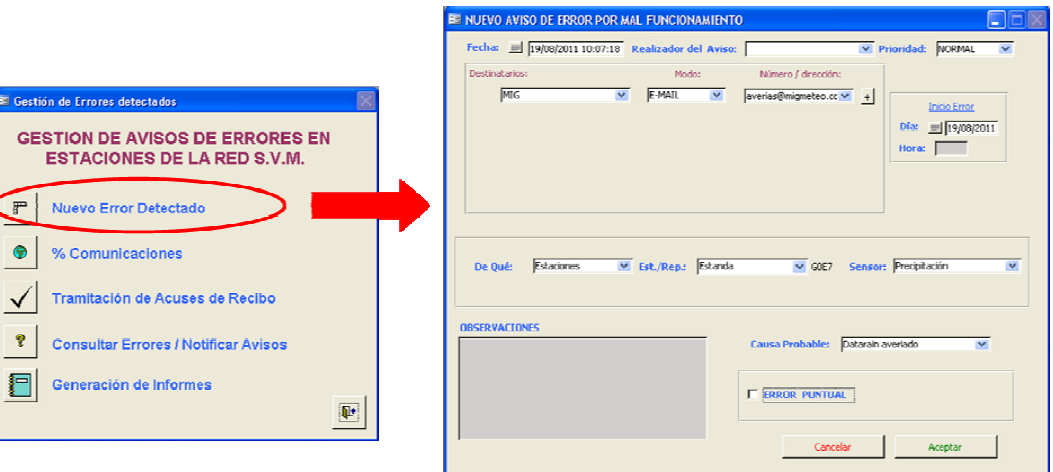
Figure 4. The alarm management software. 3